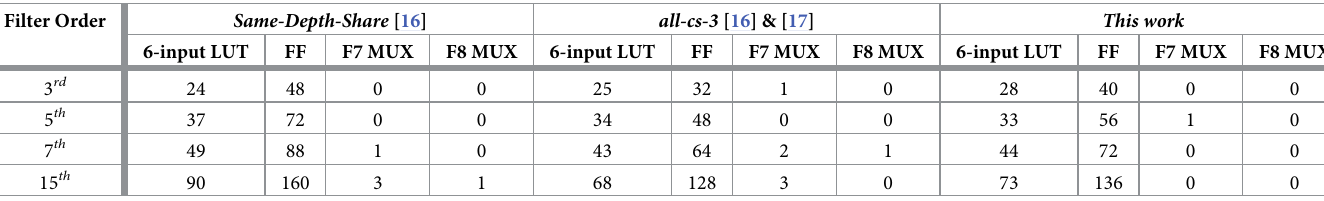
Table 4. Resource utilization on Xilinx Virtex-7 XC7VX485T FPGA. Filter